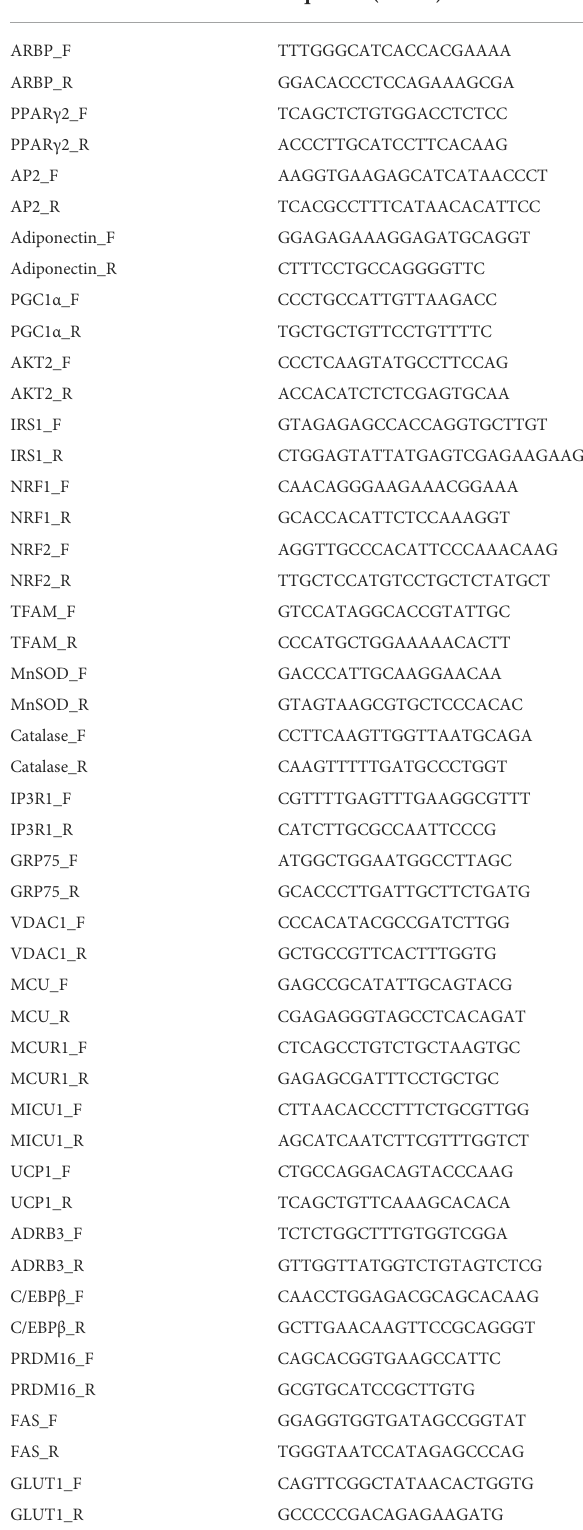
TABLE 2 The oligonucleotide sequences of primers used in this study